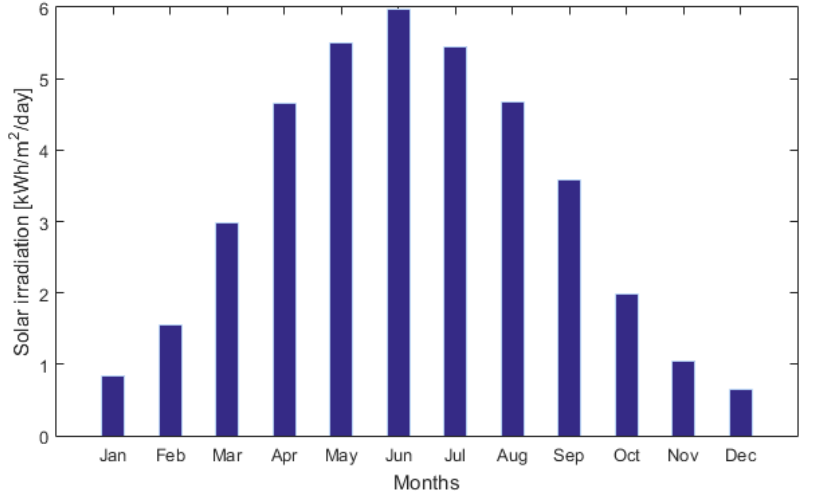
Figure 2. Monthly solar irradiation (horizontal) at Wave Hub obtained from PVGIS